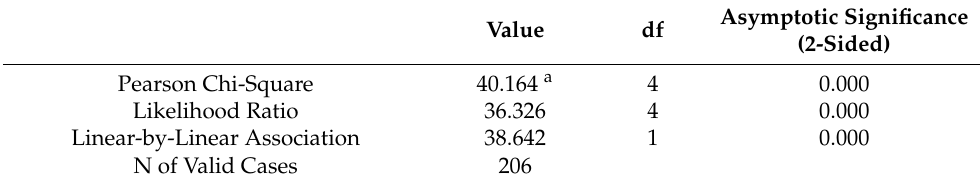
Table 5. Results of hypothesis 2 using the Chi-square test.